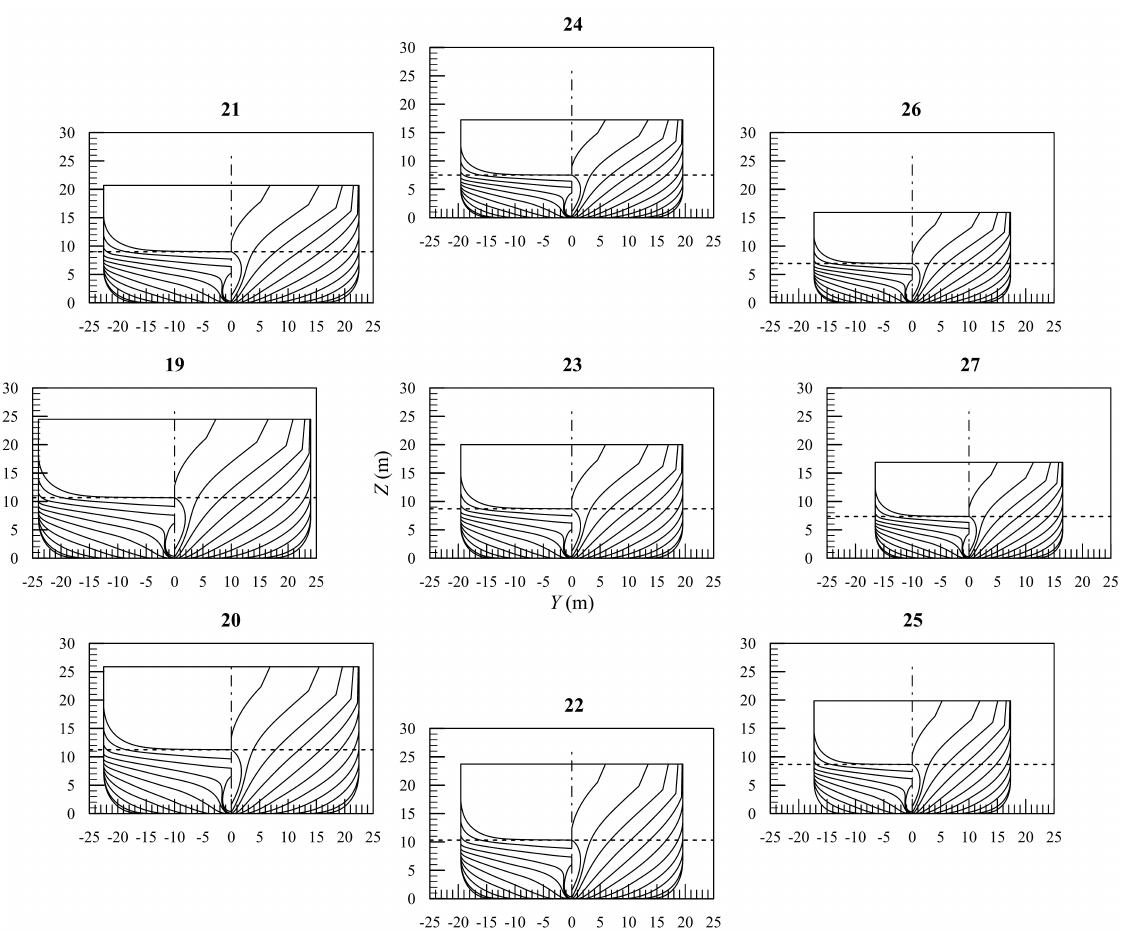
Figure 5. Body plans of one sub-family of ships having similar hull